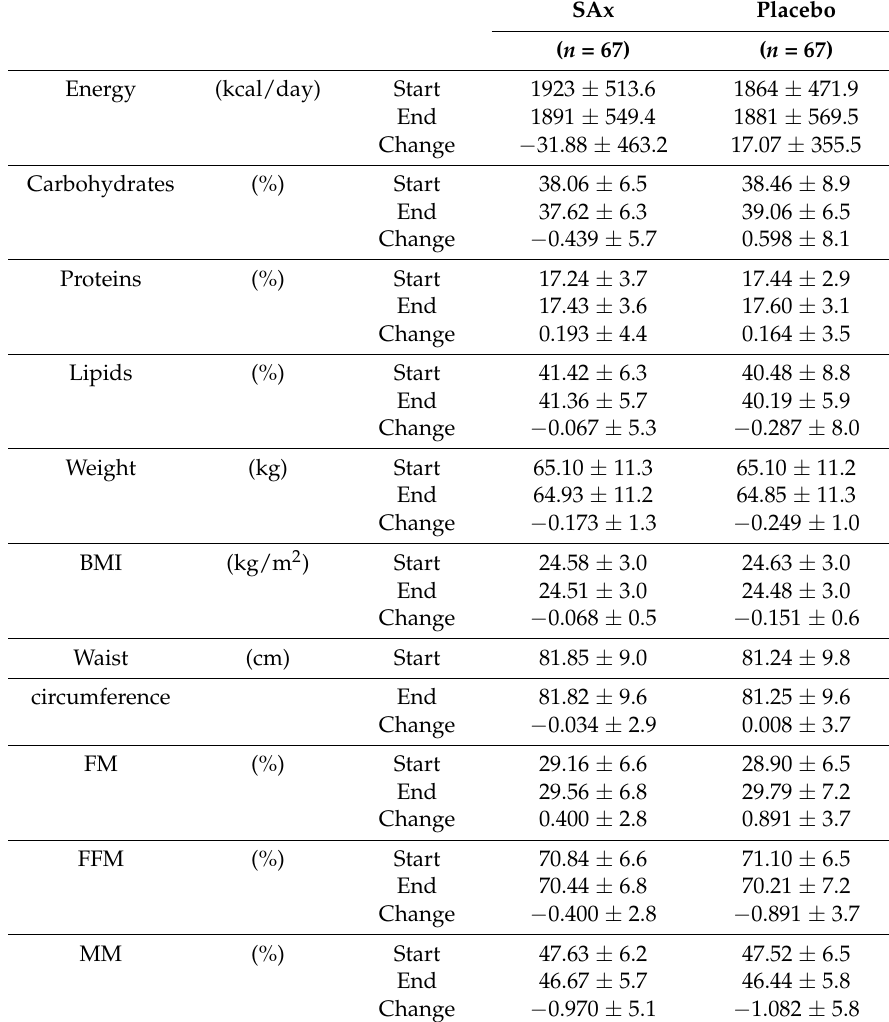
Table 2. Dietetic or anthropometric variables at the start and end of the supplementation and placebo